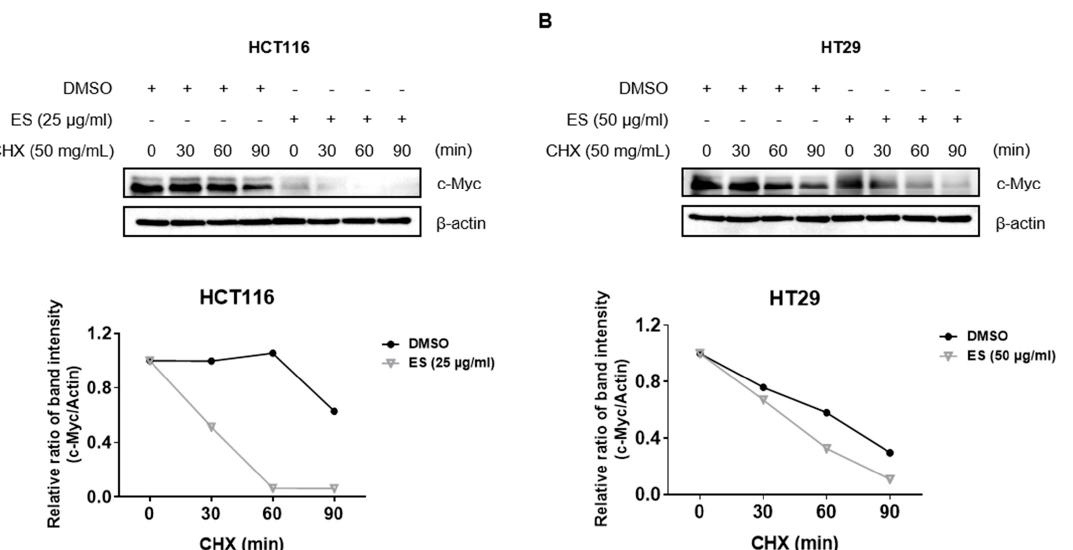
Figure 4. E ff ect of ES expression of serum-stimulated c-Myc in HCT116 cells. HCT116 cells treated